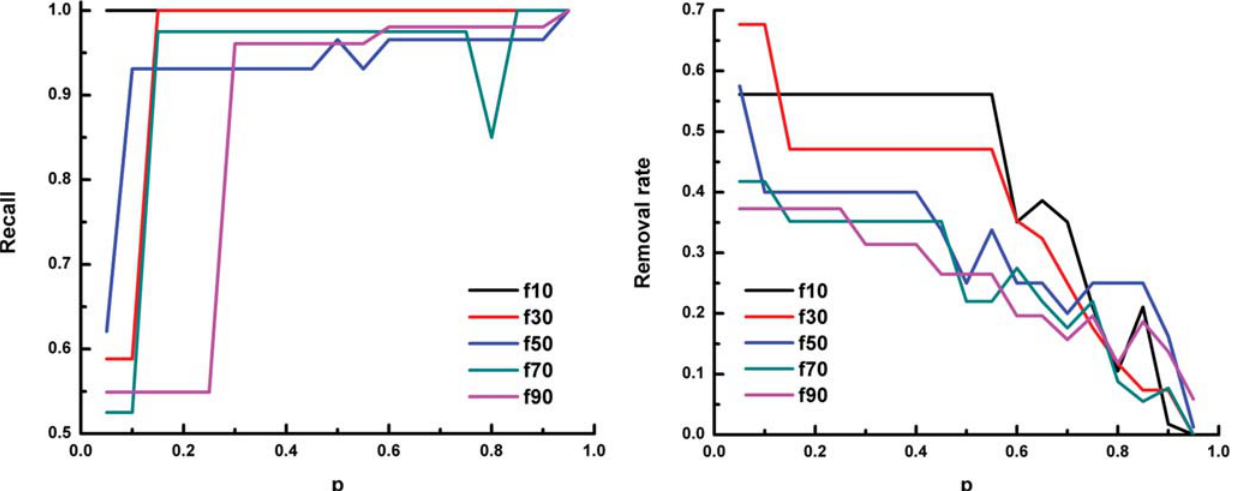
Fig 4. The recall and removal rate of prediction on Oct4-miRNA relationships using only known regulation between Oct4 and protein-coding genes. In each panel, the x-axis denotes the parameter p of SVMlight. The y-axis denotes the recall (left panel) and the removal rate (right panel) of the prediction, respectively. f10 means 10% of the known positive examples are put into the unlabeled data,and f30, (cid:3)(cid:3)(cid:3) , f90 mean 30%, (cid:3)(cid:3)(cid:3) , 90% of the know positive examples are put into the unlabeled data, respectively.